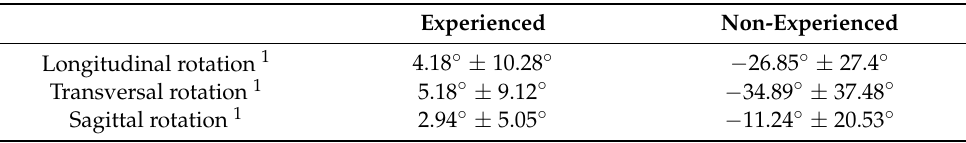
Table 5. Difference in angular orientation between the initial and retracted defensive position up- percut punch.